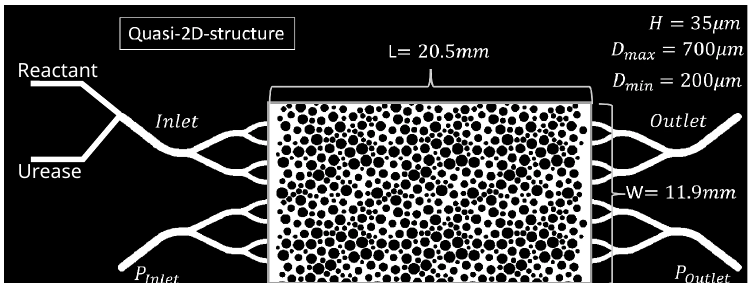
Figure 2. Sketch of the 2D EICP setup as used in this study, modified from [38].